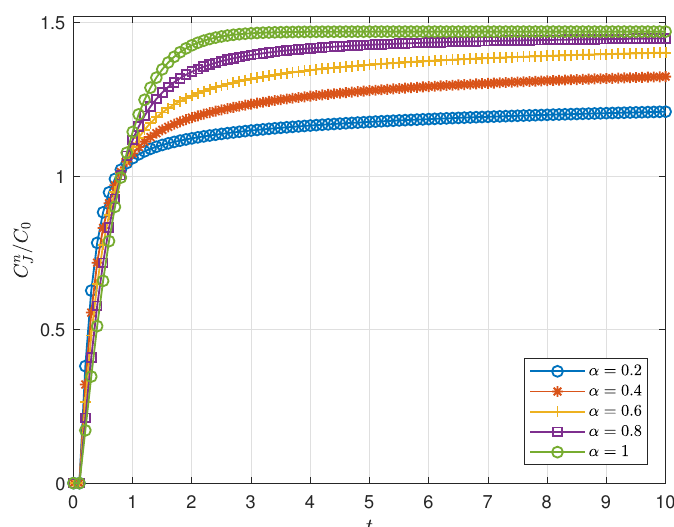
Figure 4. Breakthrough curves obtained by plotting the outflow/inflow concentration ratio ( C / C 0 ) for different values of fractional order α at final time t N .